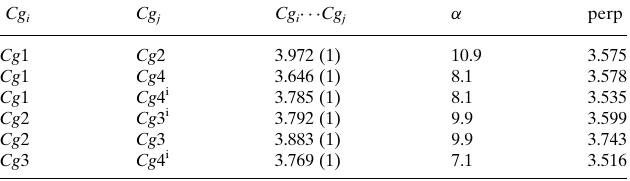
Table 2 (cid:2) – (cid:2) Stacking interactions (A˚ , (cid:1)